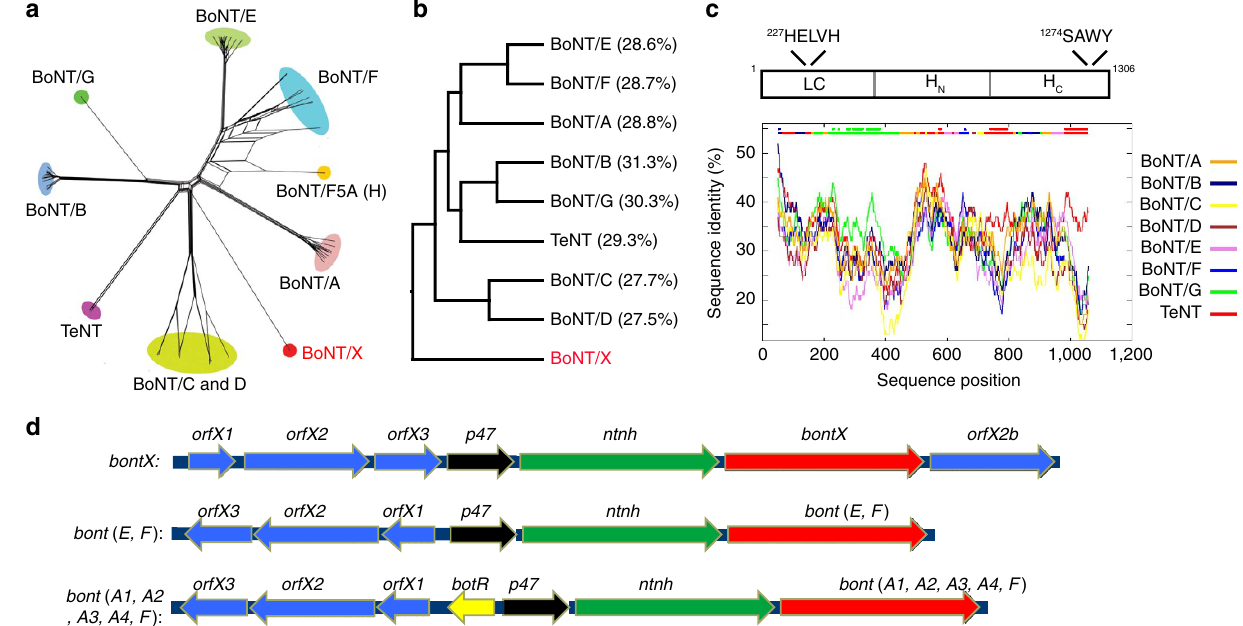
Figure 1 | Identification of BoNT/X. ( a ) A phylogenetic split network covering all BoNTserotypes, subtypes, mosaic toxins and related tetanus neurotoxin (TeNT) illustrates their potential evolutionary relationships, as well as conflicts arising from e.g. chimerisms, based on their protein sequences. BoNT/X is highlighted in red. An enlarged version of this panel is shown in Supplementary Fig. 1, with the sequence access number for each toxin gene noted. ( b ) A phylogenic tree of the protein sequence alignment for BoNT/A-G, TeNT and BoNT/X, analysed by the ClustalW method. The percentages of sequence identity between each toxin and BoNT/X are noted. ( c ) Upper panel: a schematic drawing of the three domains of BoNT/X, with conserved protease motif in the LC and the ganglioside binding motif in the H C noted. Lower panel: analysis using a sliding sequence comparison window demonstrated that the low similarity between BoNT/X and other BoNTs/TeNT is evenly distributed along the entire BoNT/X sequence. The X axis represents the query sequence position at the center of a 100-amino-acid moving sequence-comparison window. The Y axis shows the percentage of identity between that sequence window and each of the aligned background sequences. The two bars at the top of the graph illustrate the best matching sequence (lower bar) and whether the best match is significantly separated from the second-best match (upper bar). ( d ) A schematic drawing of the orf gene cluster that hosts the BoNT/X gene (upper panel), which has two distinct features compared with other known orfX clusters (middle and lower panels): (1) there is an additional orfX2 protein (designated orfX2b ) located next to the BoNT/X gene; (2) the reading frame of orfX genes has the same direction as the BoNT/X